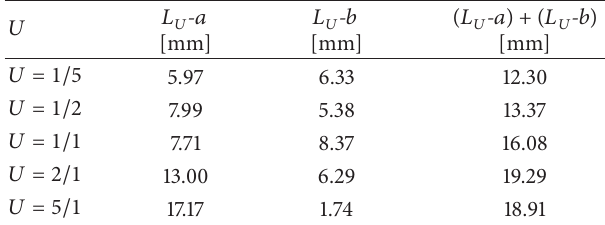
Table 2: The values of 𝐿 𝑈 - 𝑎 , 𝐿 𝑈 - 𝑏 , and ( 𝐿 𝑈 - 𝑎 ) + ( 𝐿 𝑈 - 𝑏 ) at different 𝑈